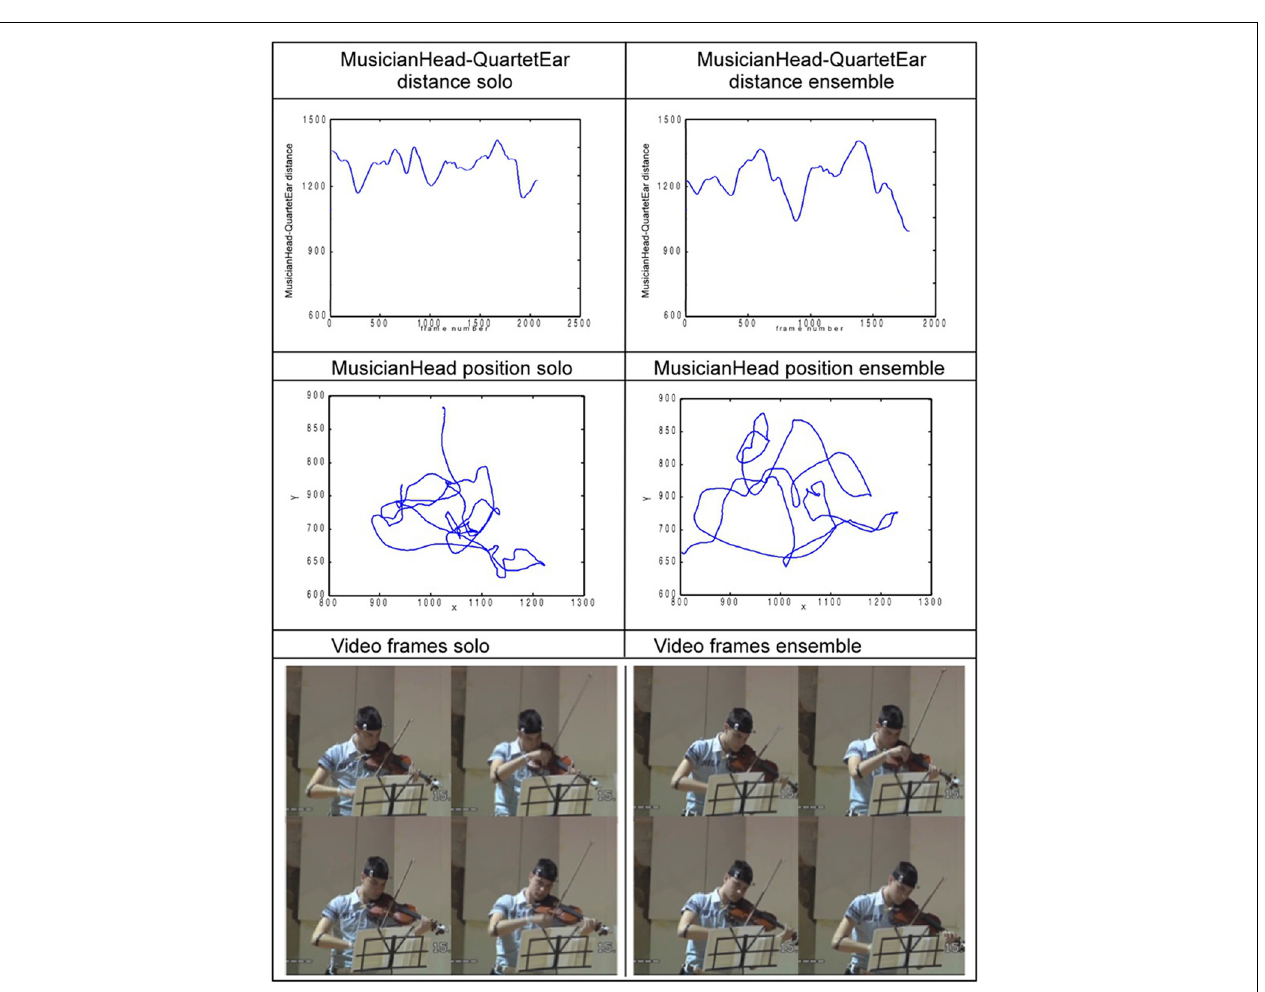
FIGURE 3 | Visualization of head data related to the first violinist of the student quartet in Solo and Ensemble conditions for a typical (brief) passage. The upper panels show distance between the head center of